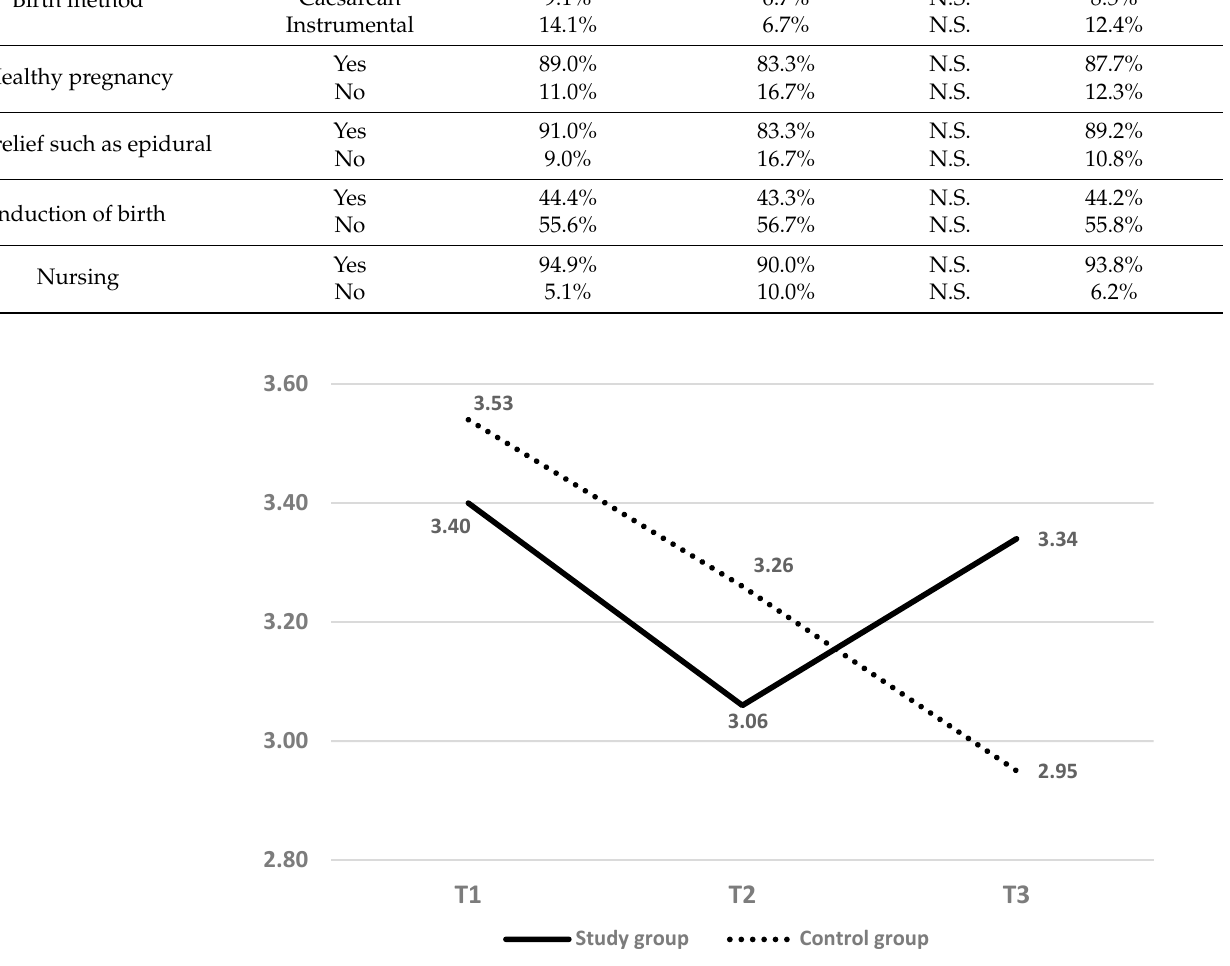
Figure 1. Mean score of childbirth self-efficacy at T 1 –T 3 (weighted of age). Table 2 further elaborates on the main and interaction